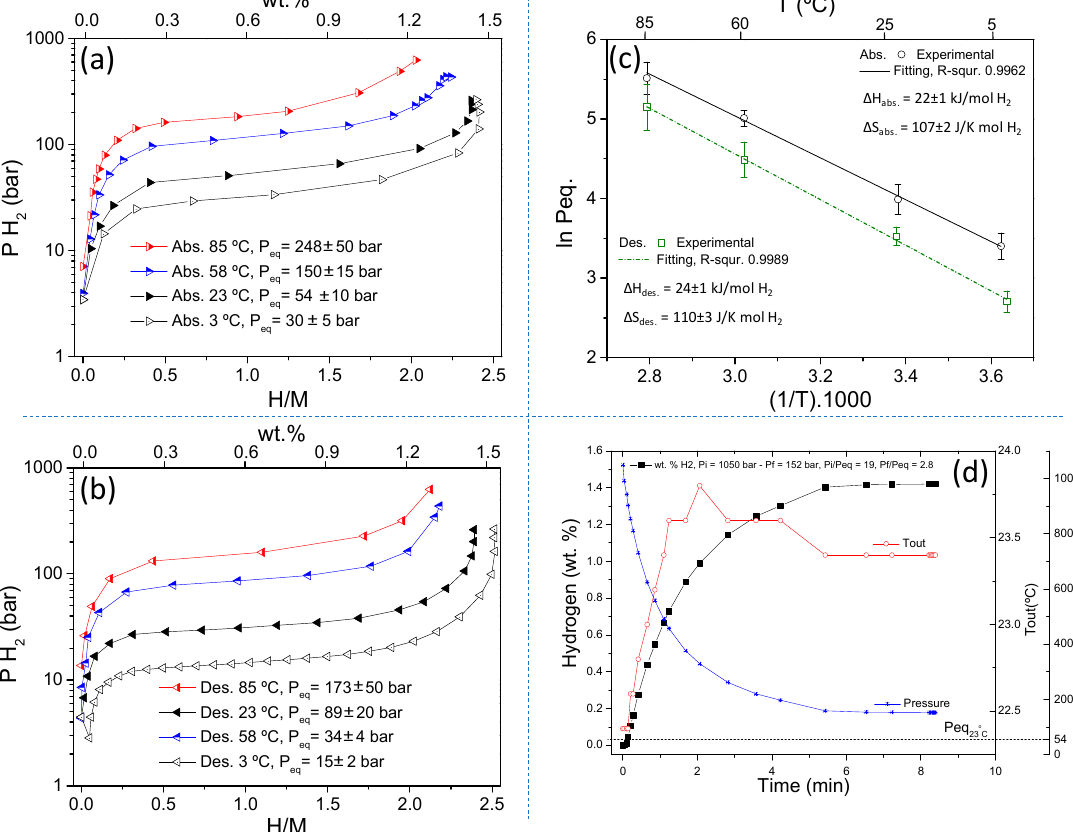
Figure 2. ( a ) Absorption and ( b ) Desorption PCIs with the respective equilibrium pressures at different temperatures, and ( c ) Absorption and desorption van‘t Hoff plots for the (Ti 0.9 Zr 0.1 ) 1.125 Cr 0.85 Mn 1.1 Mo 0.05 . ( d ) Absorption kinetic behavior under extremely high pressure and after PCI measurements (m = 12 g; high-pressure Sieverts apparatus [49]).